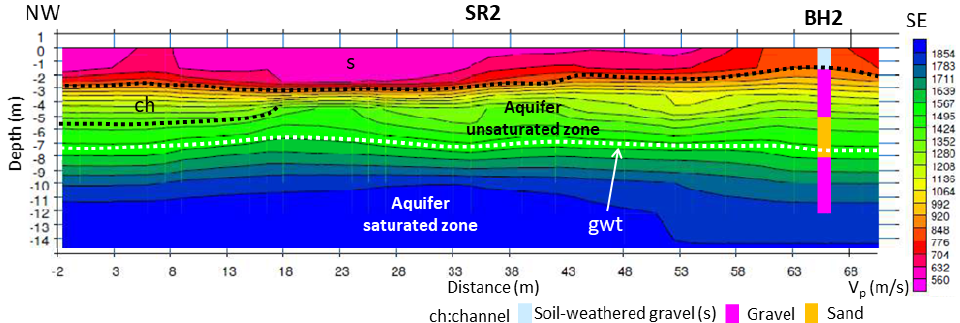
Figure 13. P-wave velocity, V P , contours of the SR1 seismic refraction survey and its geological interpretation. For the location see Figure 8. gwt: groundwater table; BH1 and BH2 refer to the boreholes.